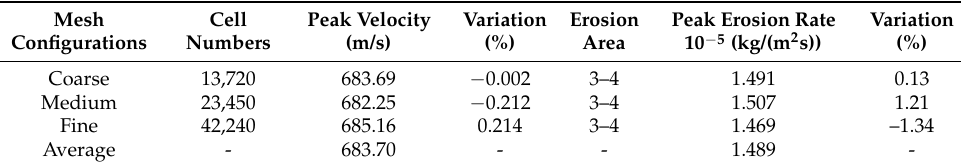
Figure 5. The finite element mesh of the contraction section. Table 1. Convergence study of the mesh